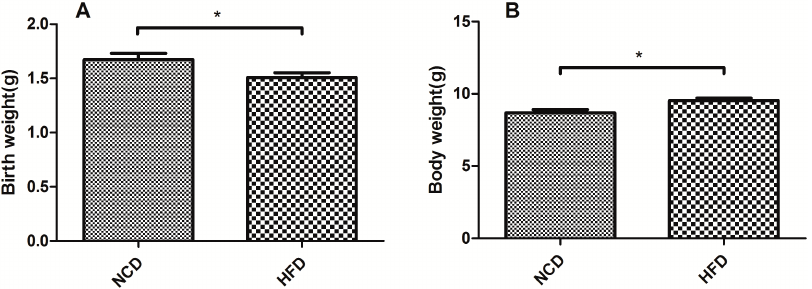
Figure 1. Birth weight and body weight at weaning in the offspring from the high-fat diet and normal chow diet groups. ( A ) Birth weight; and ( B ) body weight. Data represented as the mean ± standard deviation (S.D.) ( n = 16, per group, 8 male and 8 female). * p < 0.05 vs. the normal chow diet group. HFD, high-fat diet; NCD, normal chow